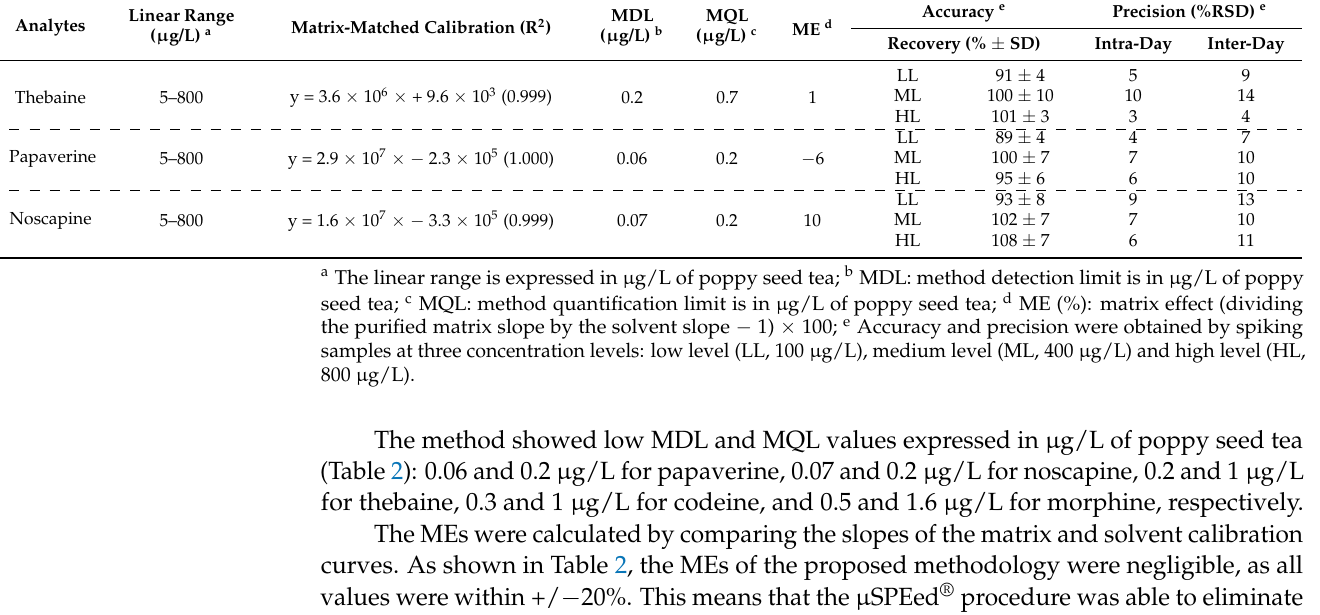
(Table 2): 0.06 and 0.2 µ g/L for papaverine, 0.07 and 0.2 µ g/L for noscapine, 0.2 and 1 µ